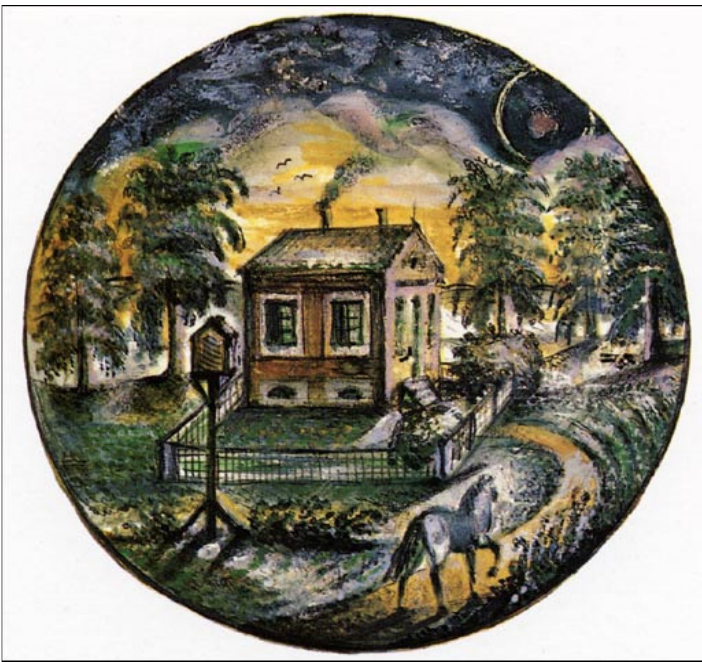
Figure 37. Konstantin Batiushkov. Landscape with a House , 1830 (?). Literary Museum of the Institute of Russian Literature (Pushkin House) of the Russian Academy of Sciences, Saint Petersburg.